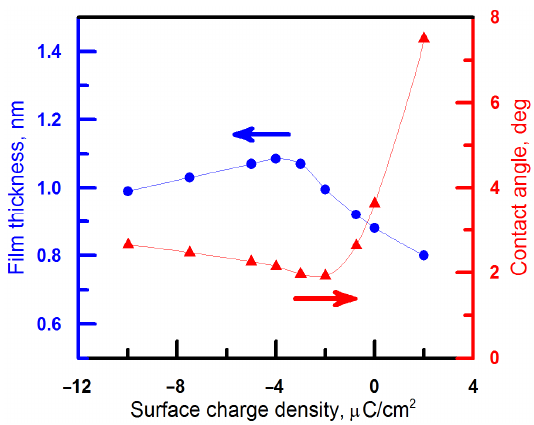
Figure 5. Calculated dependences of pentane wetting film thicknesses and of the contact angle formed by the pentane droplet on the surface of the aqueous phase versus the surface charge density.